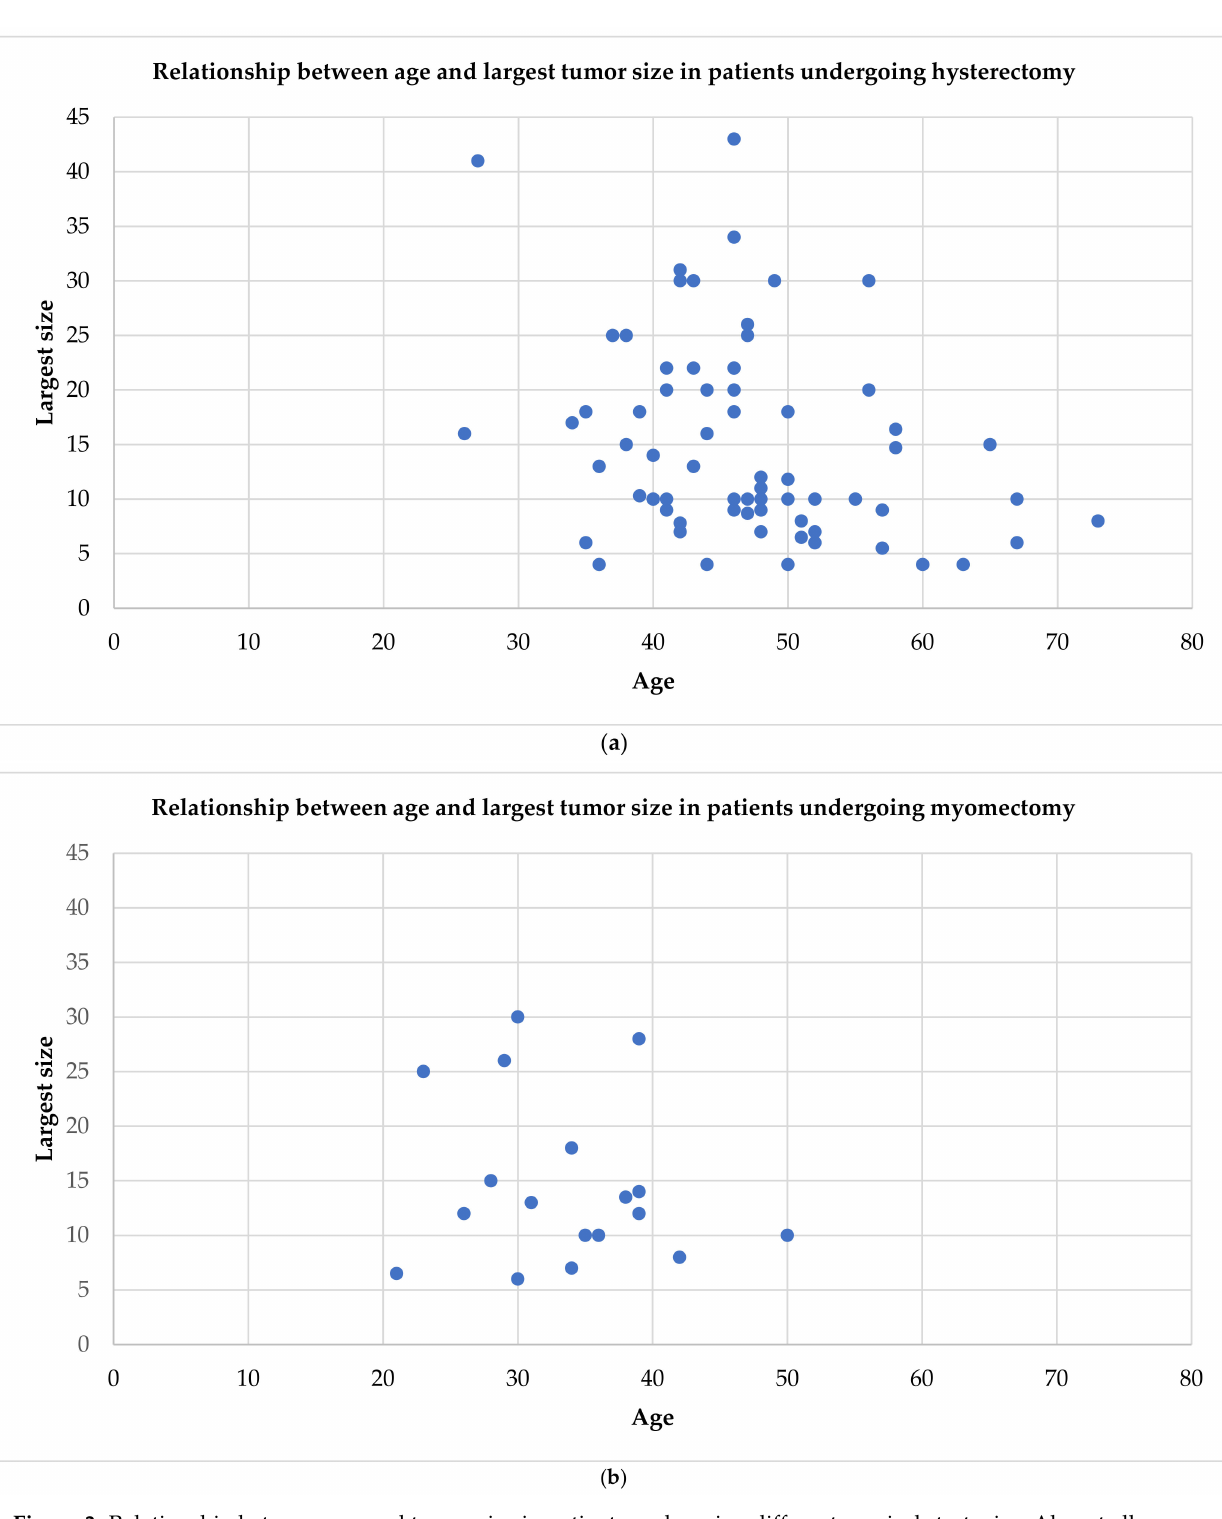
Figure 3. Relationship between age and tumor size in patients undergoing different surgical strategies. Almost all women between 40 and 50 years who have a cotyledonoid leiomyoma of 10–30 cm undergo hysterectomy ( a ). Conversely, for women of childbearing age between 20 and 40 years, myomectomy is attempted to save the uterus, regardless of the size of the tumor (even for sizes between 25 and 30 cm) ( b